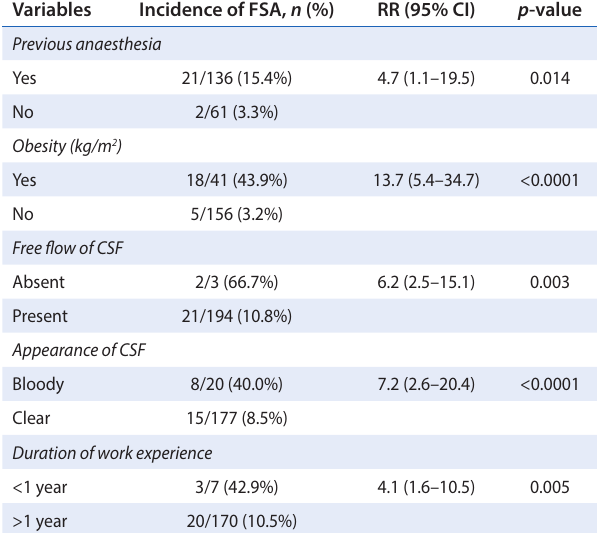
Table 3: Determinants of failed spinal anaesthesia